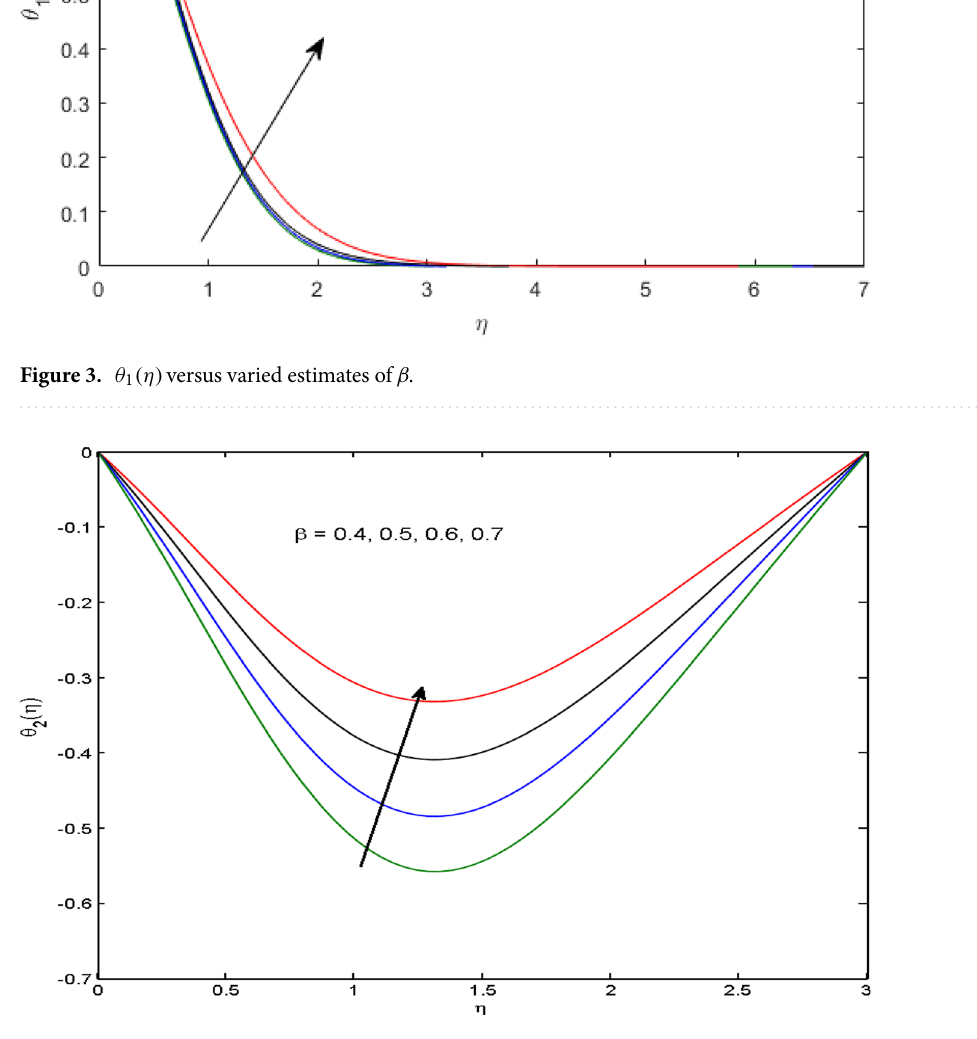
Figure 4. θ 2 (η) versus varied estimates of β